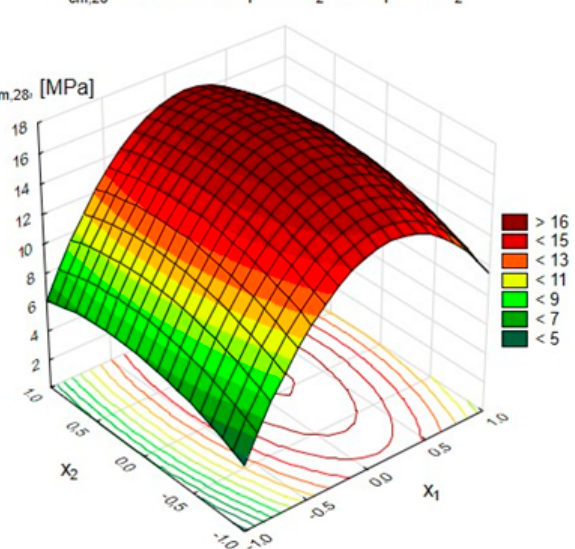
Figure 6. Compressive strength of the GLC after 28 days depending on x 1 and x 2 at x 3 = 0 (10 M).